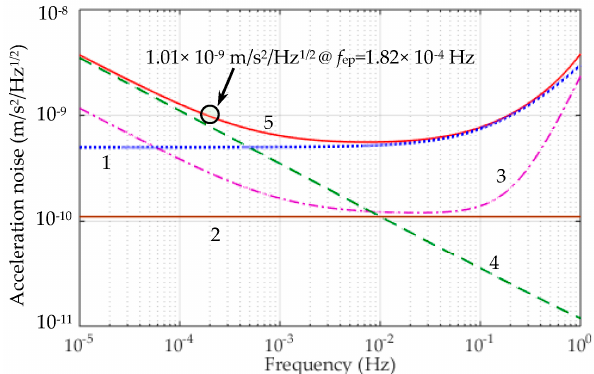
Figure 10. Acceleration noise budget for the sensitive axis of the NEP instrument. The lines 1, 2, 3, 4 and 5 represent the differential acceleration coupling from the residual non-gravitational acceleration, temperature effect, position sensing induced noise, electrostatic actuation noise and total NEP instrument noise, respectively.